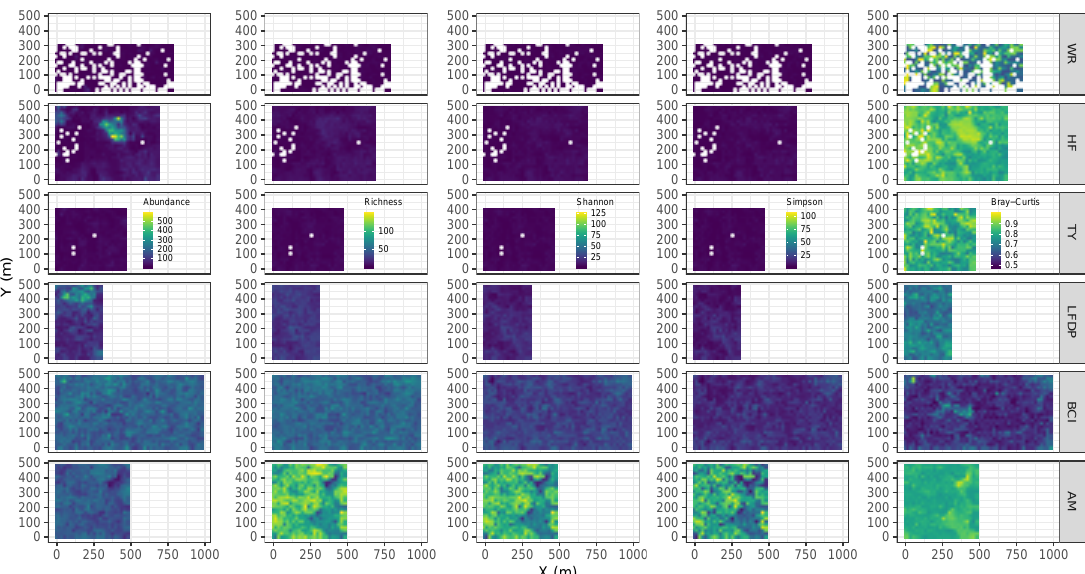
Figure 7. Abundance, species richness, two measures of species diversity, and one measure of beta diversity for all species other than the focal species (Table 1) in the six 20-m rasterized forest dynamics plots. Sites are ordered top-to-bottom by decreasing latitude, and each plot is scaled relative to the 50-ha BCI plot. White squares in the WR, HF, and TY panels indicate that only the focal species were present in that subplot.